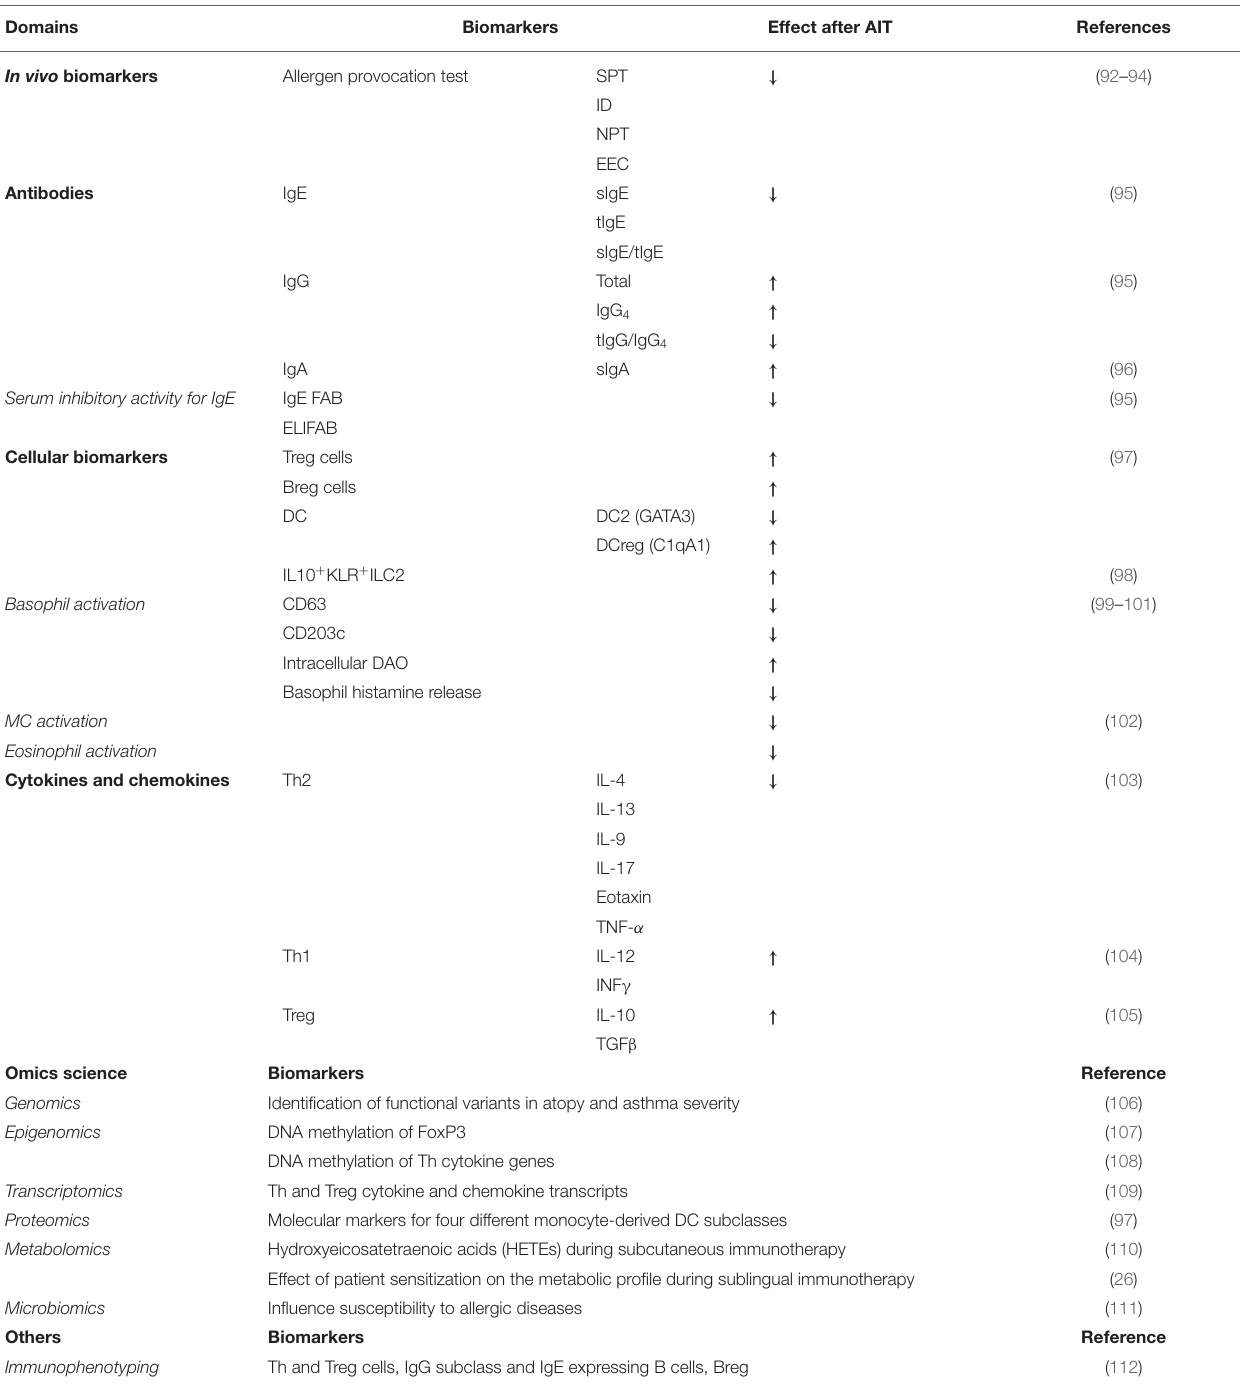
TABLE 1 | Potential biomarkers in